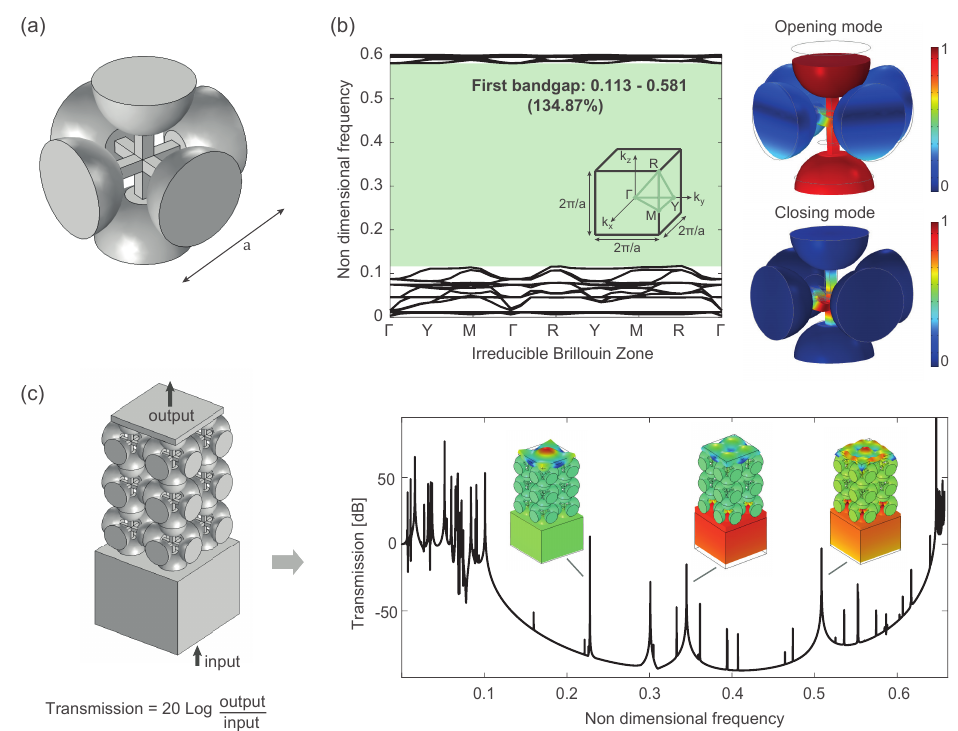
Figure 1. ( a ) Unit cell of the proposed phononic crystal, with a the dimension of the cubic cell. ( b ) Non-dimensional dispersion diagram with non-dimensional frequency f nd = f a / v . The irre- ducible Brillouin zone (IBZ) and the bandgap opening and closing modes are also reported. ( c ) Non- dimensional transmission diagram computed on a 2 × 2 × 3 phononic crystal. The input is prescribed as a z -axis displacement at the bottom surface of the glass support, while the output is measured as the average z -axis displacement of the top plate (black